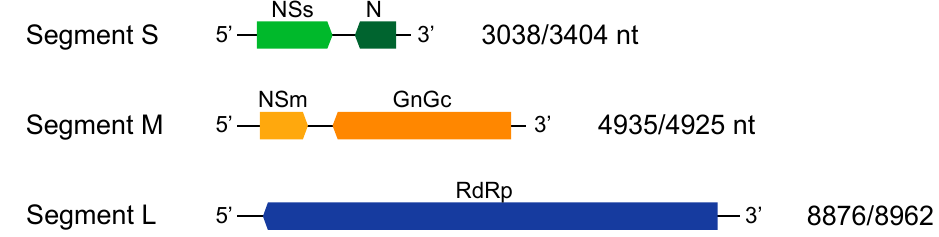
Figure 2. Genomic organization of TCSV and GRSV. The numbers on the right indicate the length of each segment of isolates SA-05 (GRSV) and BR-03 (TCSV), respectively.